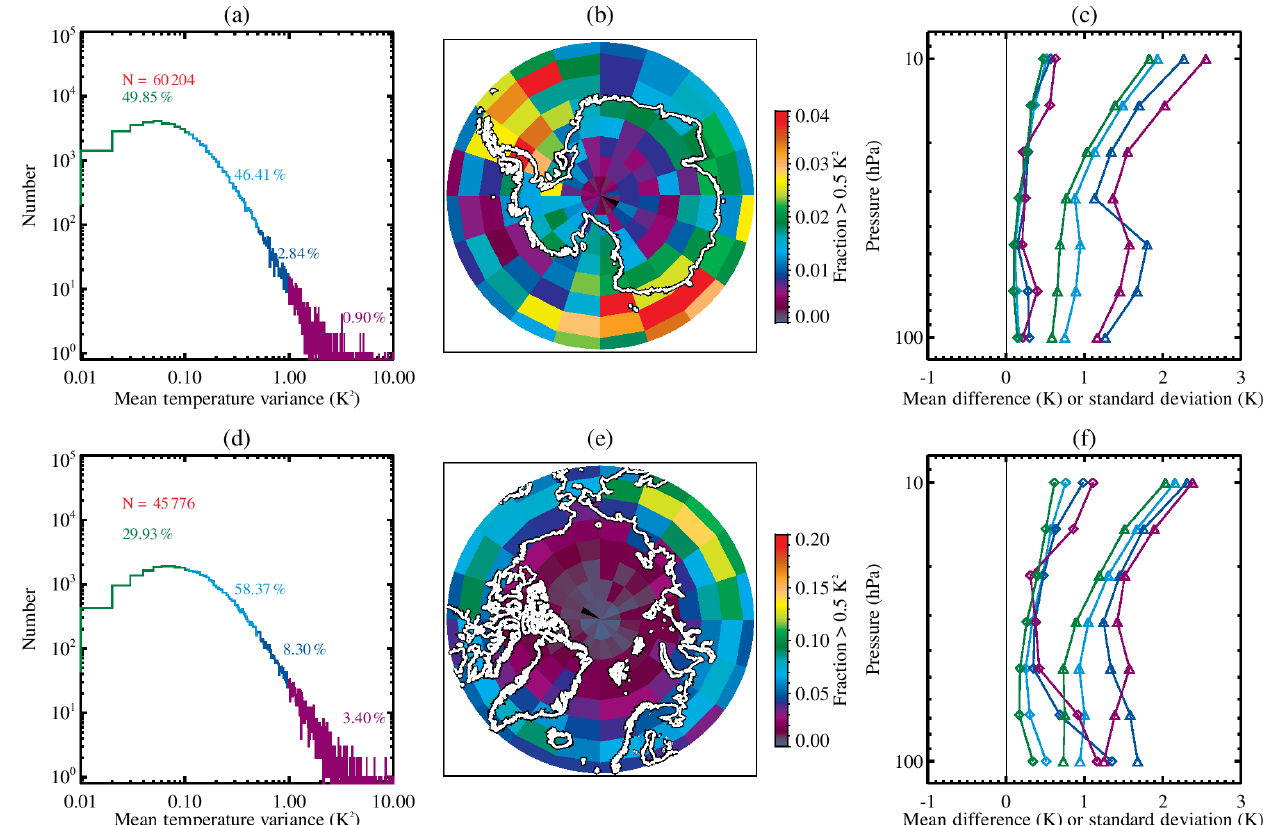
Figure 4. Temperature variance, σ 2 = T (cid:48) 2 , in K 2 , of the COSMIC profiles averaged over the pressure range 80–20hPa for 2008–2013 for the Antarctic and Arctic. (a, d) Histogram of the mean COSMIC temperature variance with color coding for σ 2 ≤ 0 . 1K 2 (green), 0 . 1K 2 > σ 2 ≤ 0 . 5K 2 (cyan), 0 . 5K 2 > σ 2 ≤ 1 . 0K 2 (blue), and σ 2 ≥ 1 . 0K 2 (purple). N is the total number of profiles, and the percentages falling in each of the four colored σ 2 regions are also given. (b, e) Geographic distribution of the fraction of COSMIC profiles with σ 2 > 0 . 5K 2 . (c, f) Mean values (diamonds) and standard deviations (triangles) of the temperature differences between ERA-I and COSMIC, color coded for the COSMIC temperature variance as given in panels (a, d) . The estimated noise variance is about 0.03K 2